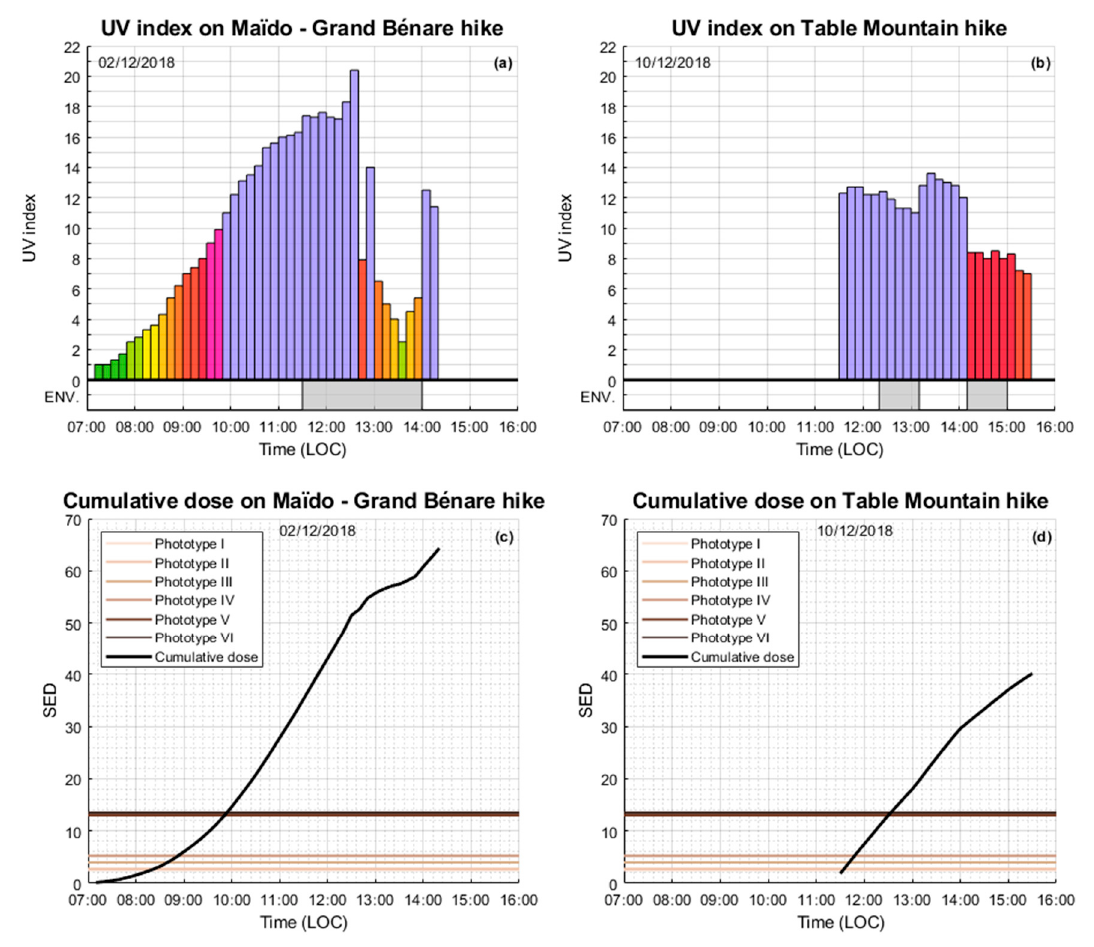
Figure 7. UV index recorded at Maïdo–Grand Bénare hike ( a ) and Table Mountain hike ( b ). The colors on the histogram represent also the UV index following the standard UV index color scale. The grey surface at the bottom of the figure shows environmental effects affecting UV radiation, mainly cloud cover or shade. The corresponding cumulative doses at Maïdo ‐ Grand Bénare hike ( c ) and Table Mountain hike ( d ). The black line represents the cumulated dose. The horizontal lines show the threshold for 1 dose to sunburn (Table 1) as function of skin phototype.